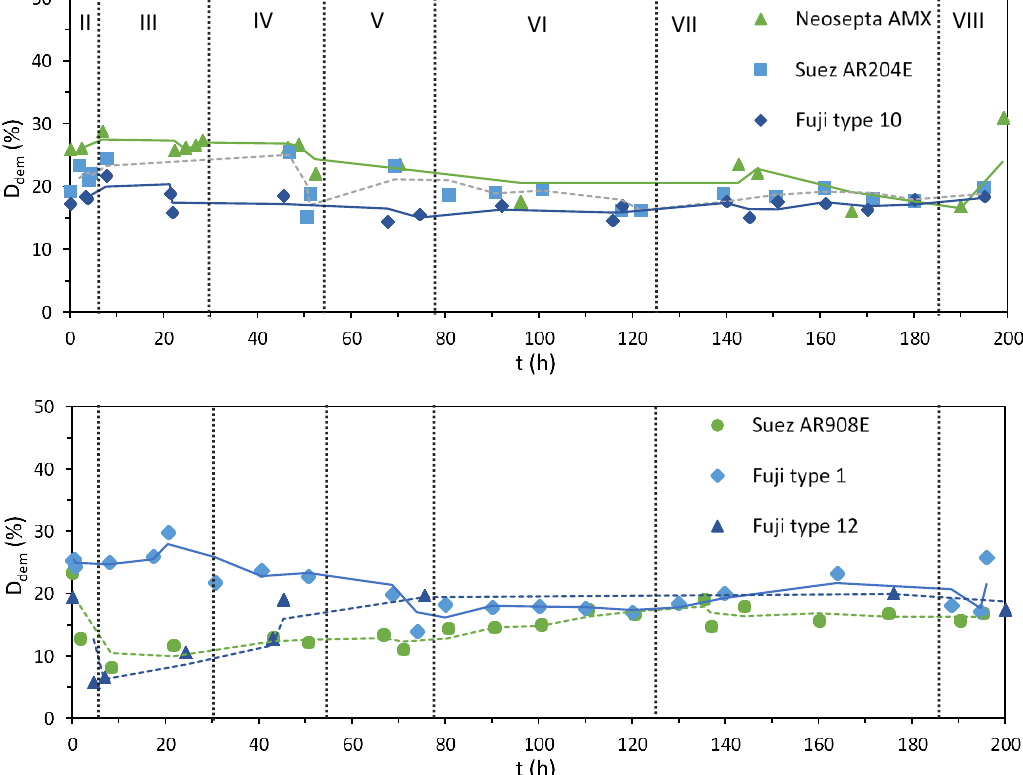
Figure 4. Demineralization after a single pass (%) vs. time during the EDR runs performed with di ff erent AEMs. Calculated values are represented by the symbols, and continuous trendlines (calculated as moving average) are included only for guiding the eye. The change of stage is represented by the vertical